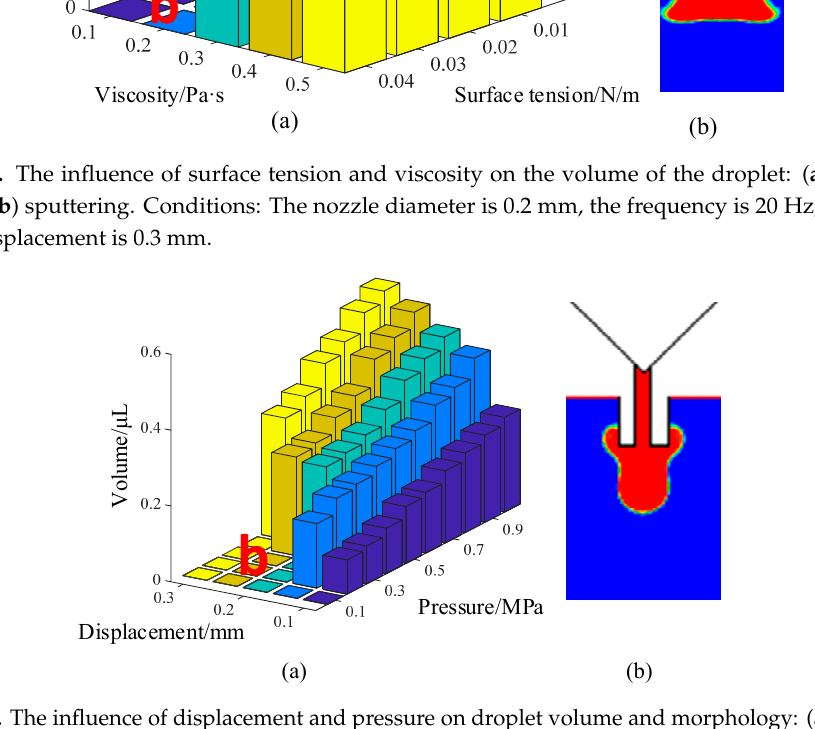
Figure 11. The influence of displacement and pressure on droplet volume and morphology: ( a ) Jetting volume; ( b ) adhesion. Conditions: The nozzle diameter is 0.2 mm, the viscosity is 0.8 Pa · s, the frequency is 20 Hz, and the surface tension is 0.06 N / m.